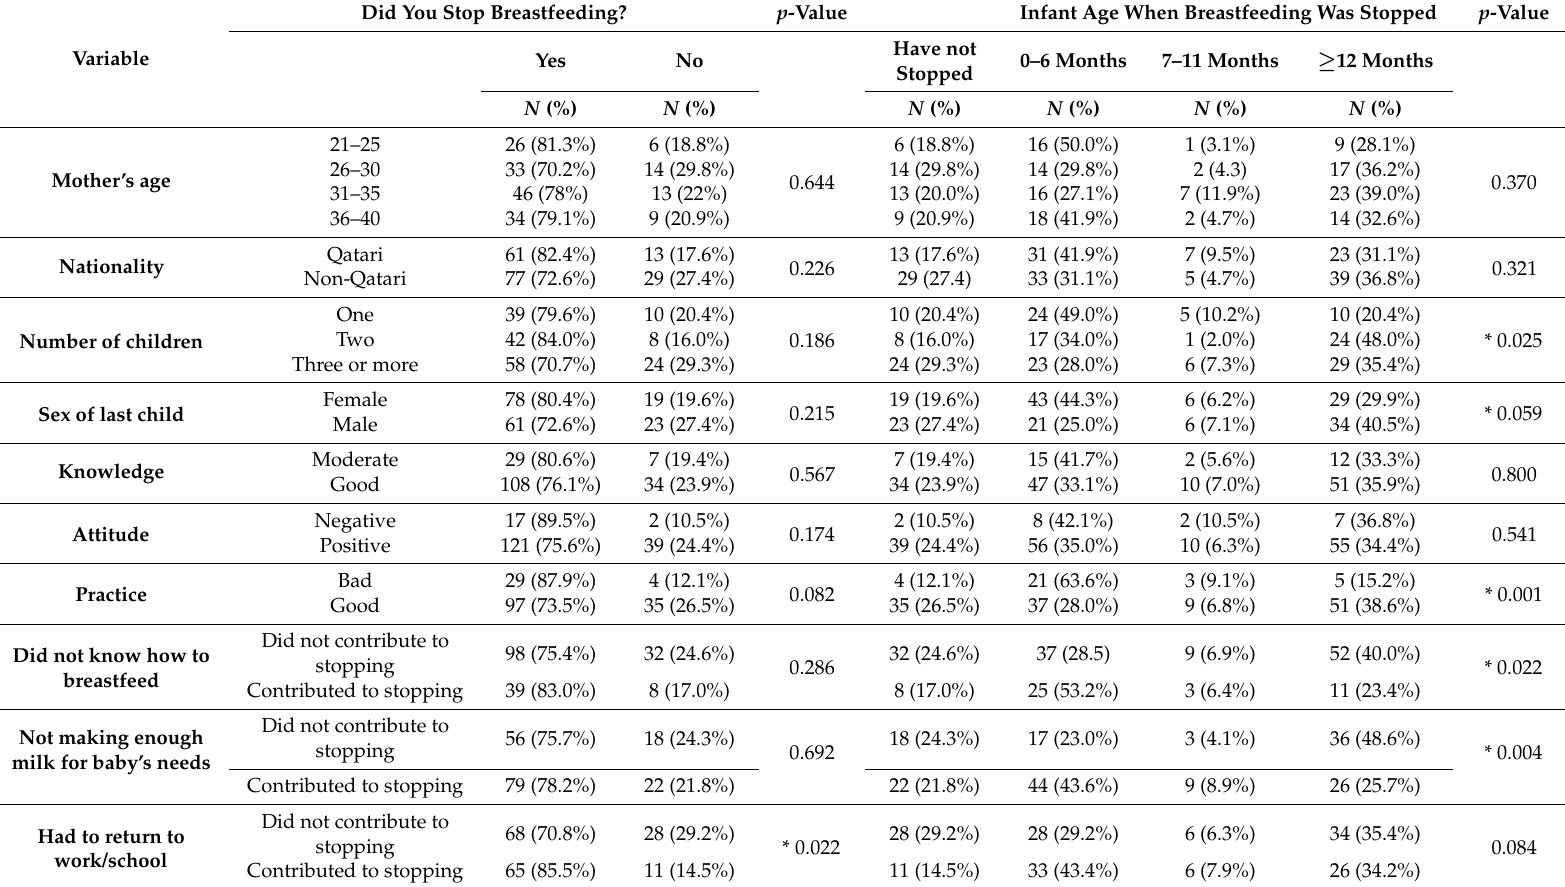
Table 4. Association between sociodemographic and lifestyle variables and